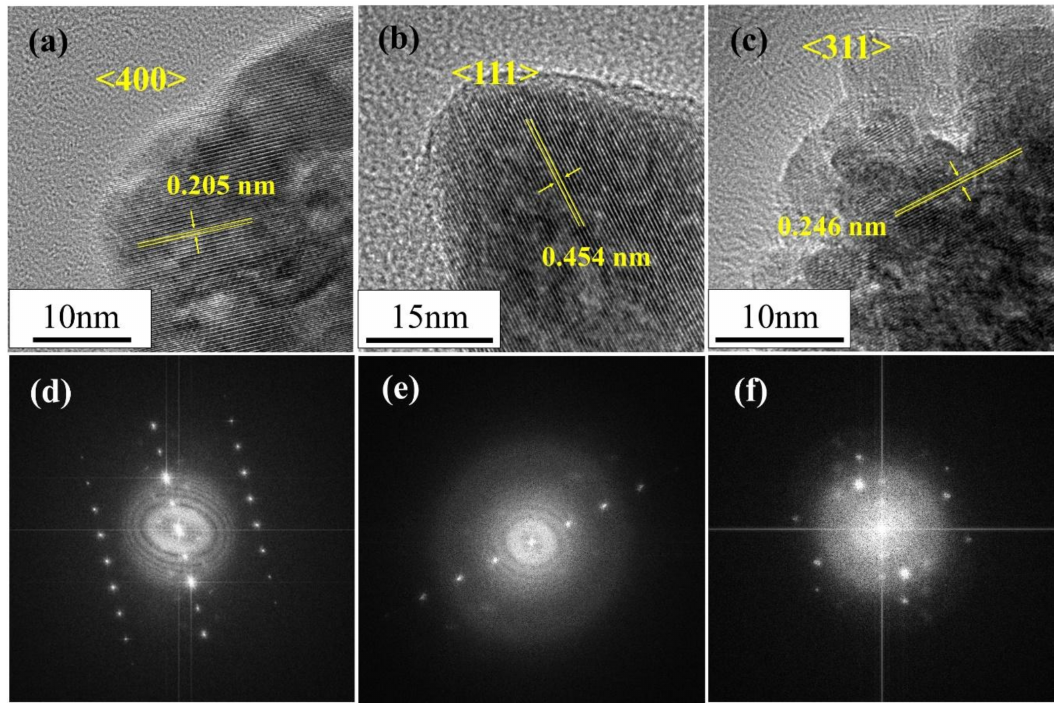
Figure 4. High-resolution transmission electron microscopy (HR-TEM) images and fast Fourier transform (FFT) diffraction patterns of ( a,d ) randomly shaped; ( b,e ) cube-like; and ( c,f ) raspberry-shaped Co 3 O 4 nanoparticles.